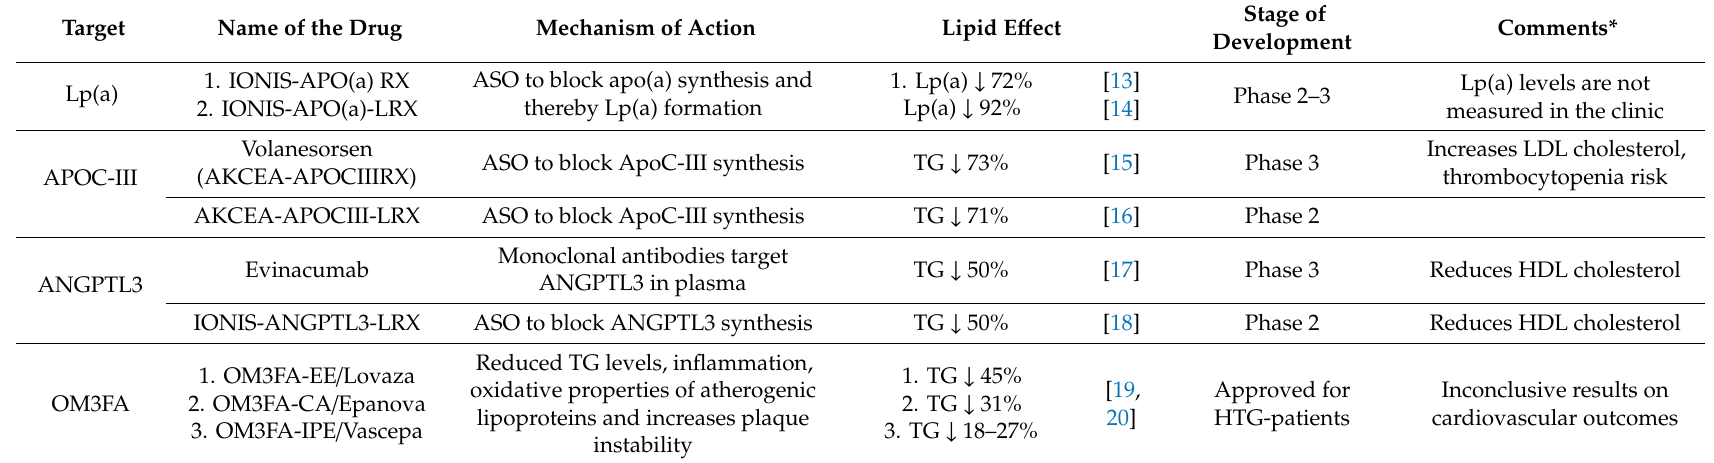
Table 1. Targeting risk of plasma lipid-driven atherosclerotic cardiovascular disease beyond LDL